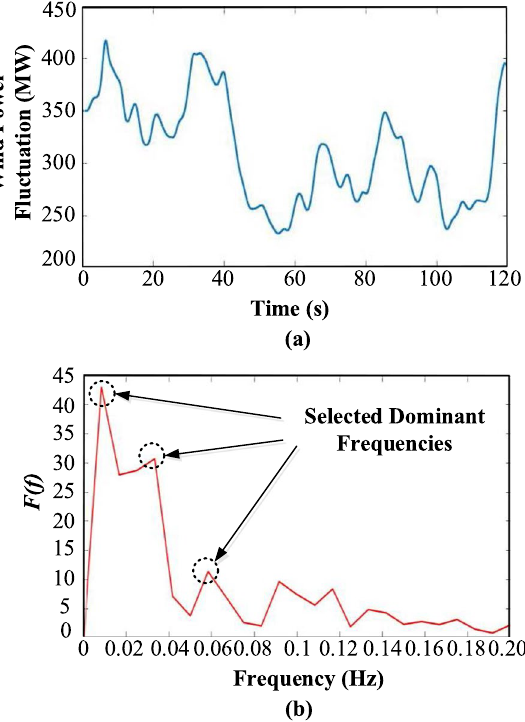
Fig. 8 a The wind power fluctuation in a typical operating scenario, b The frequency spectrum of the wind power